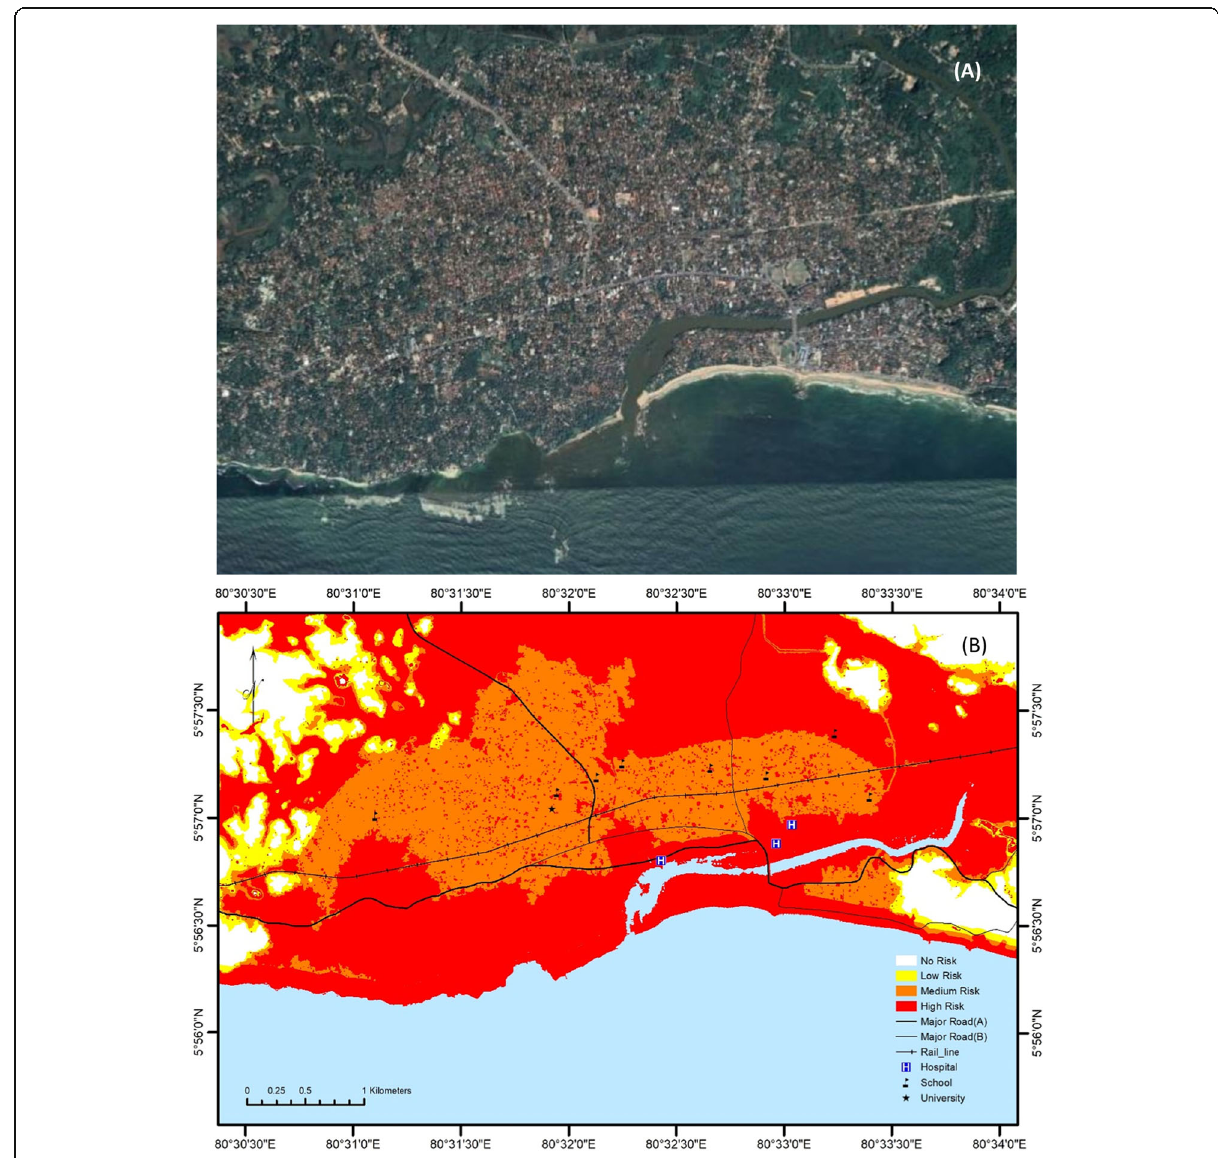
Fig. 7 ( a ) Satellite image of Matara, and ( b ) risk assessment map of the